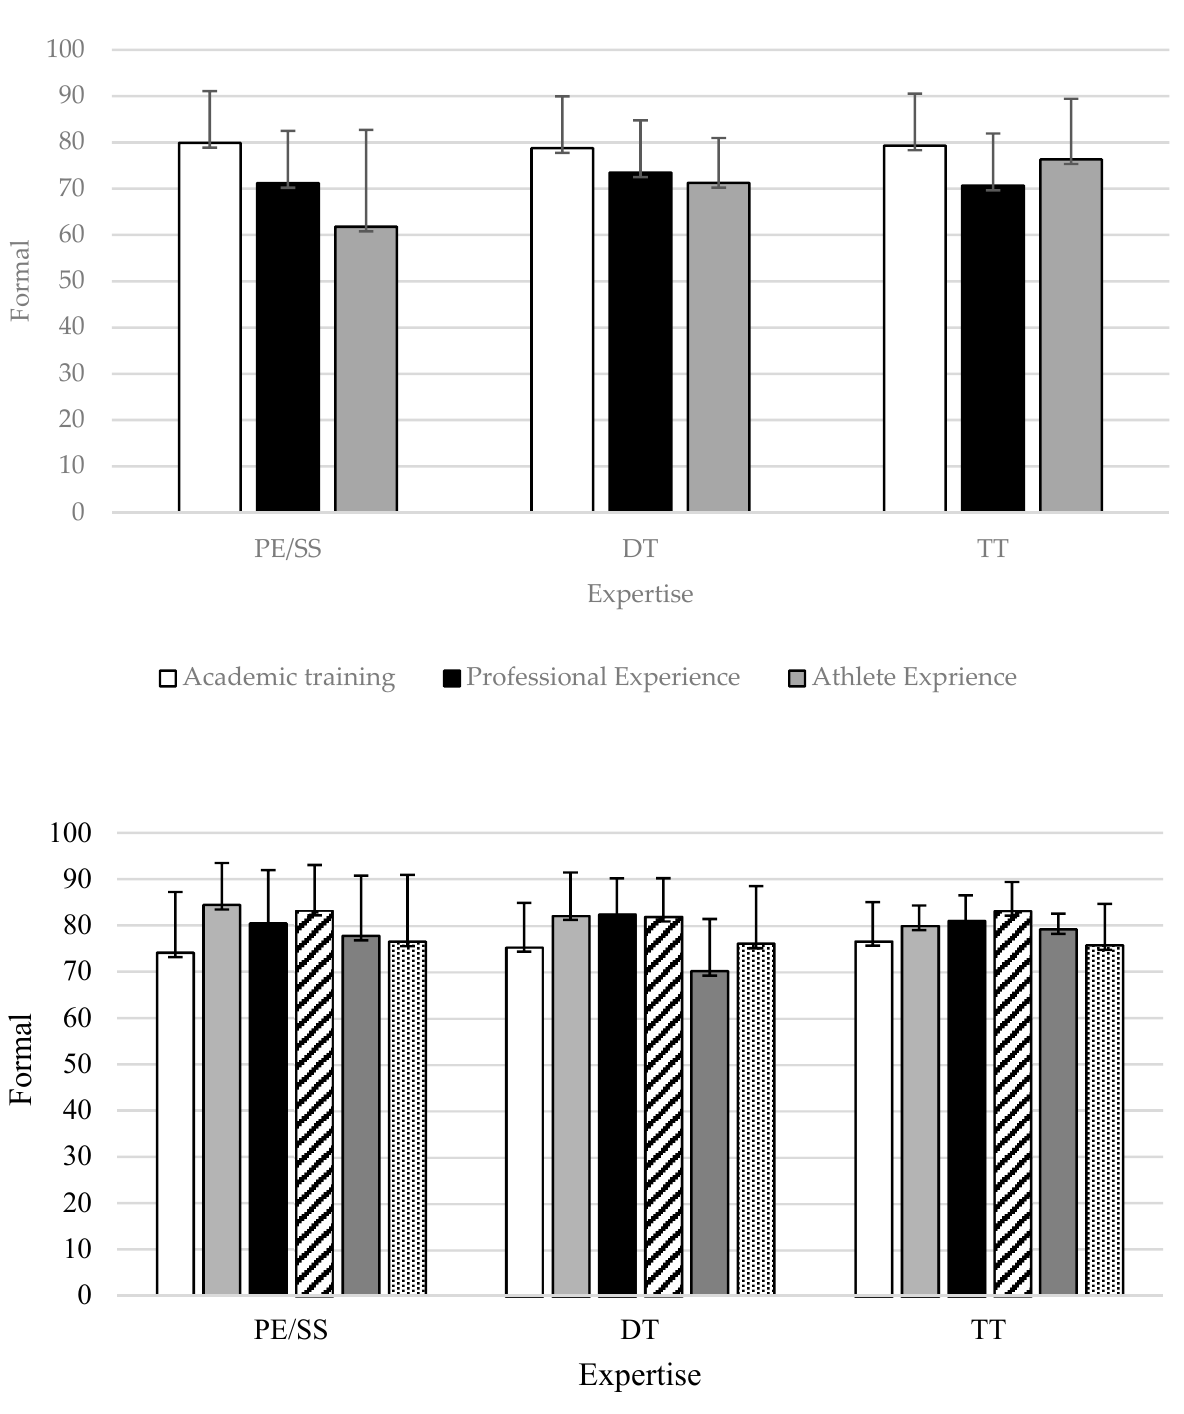
Figure 1. Descriptive statistics of the relationship between the training and profile of SOPC and formal learning.